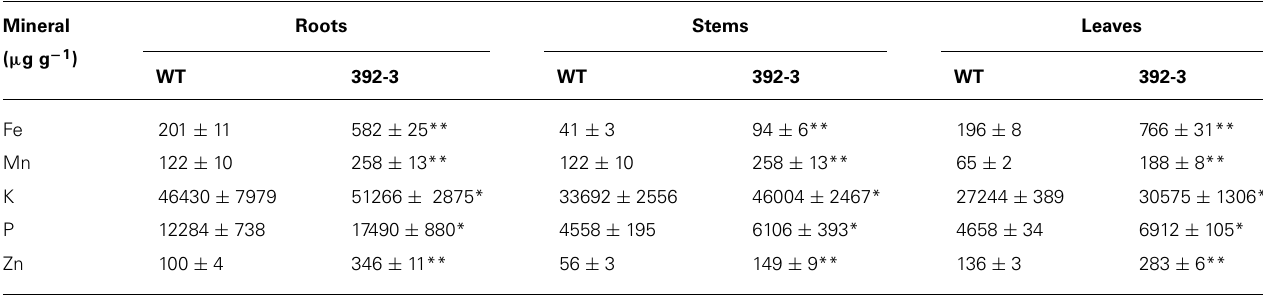
Table 1 |Average root, stem, and leaf mineral concentration of wild-type (WT) and 392-3 transgenic soybean plants grown in hydroponic conditions with 32 μ M Fe(III)-EDDHA for 2 weeks.